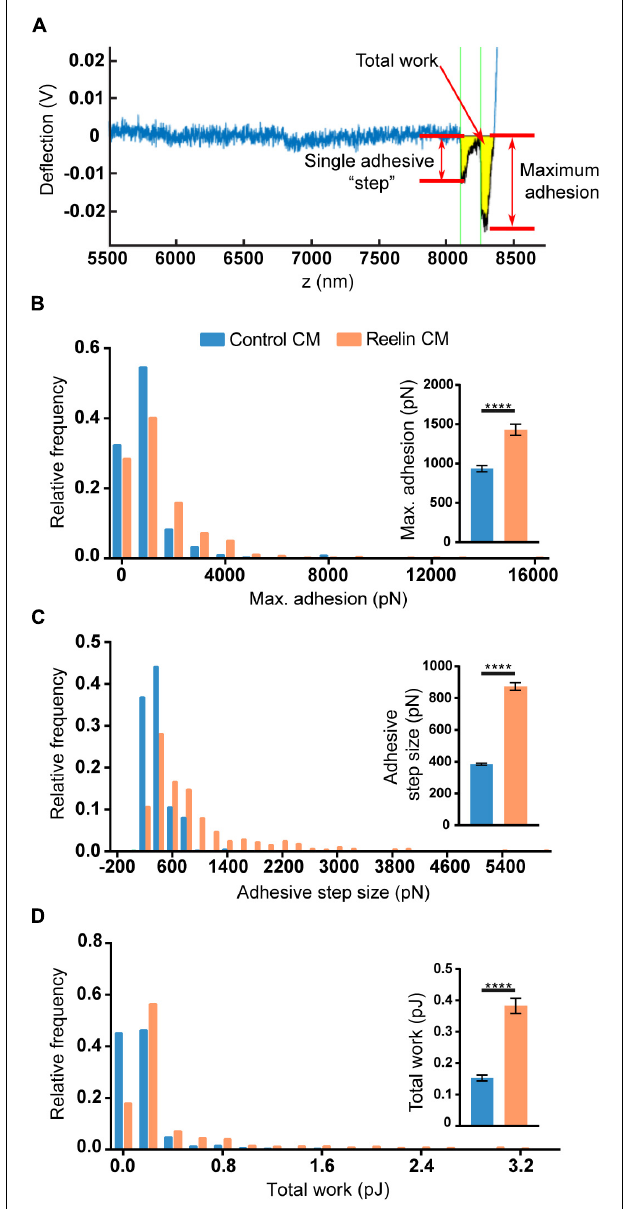
FIGURE 10 | Reelin increases NPC adhesiveness to N-cadherin. (A) Example trace generated by AFM from an N-cadherin-coated cantilever in contact with a single cell. From each trace, adhesive step size, maximum adhesion, and total work (yellow shading) were calculated. Thirty-minute treatment of WT NPCs with conditioned media (CM) from Reelin-transfected HEK293T cells increases (B) maximum adhesion, (C) adhesive step size, and (D) total work compared to CM from pcDNA3-transfected HEK293T cells (control CM) ( n = 402–536 from two biological replicates). Distributions are significantly different ( p < 0.0001 by Kolmogorov–Smirnov test). Inset graphs show average values. **** p < 0.0001 by Mann–Whitney test.